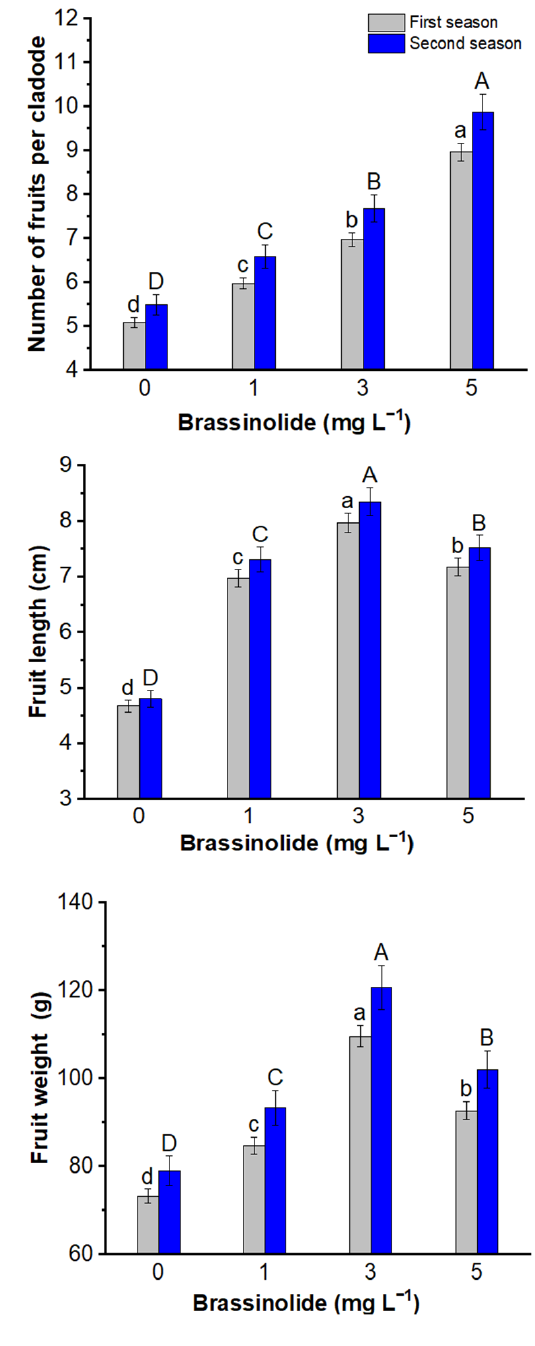
Figure 1. Number of flowering cladodes plant − 1 , number of fruits cladode − 1 , harvesting date, fruit length (cm), fruit width (cm), and fruit fresh weight (g) of prickly pear plant subjected to brassinolide foliar spray. Data are mean value ± SE. Bars with the same letters (lowercase for the first season and uppercase for the second season) are not significant at p ≤ 0.05 level. a, b, c, and d letters are concerning the first season. A, B, C, and D